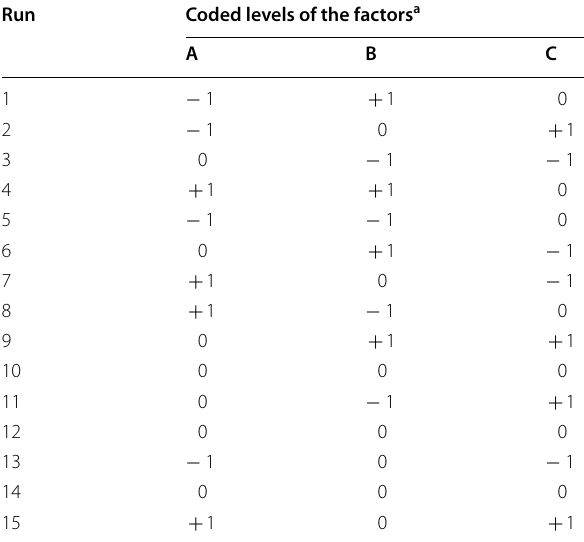
Table 3 Coded levels of factors in the experiments suggested by Box–Behnken